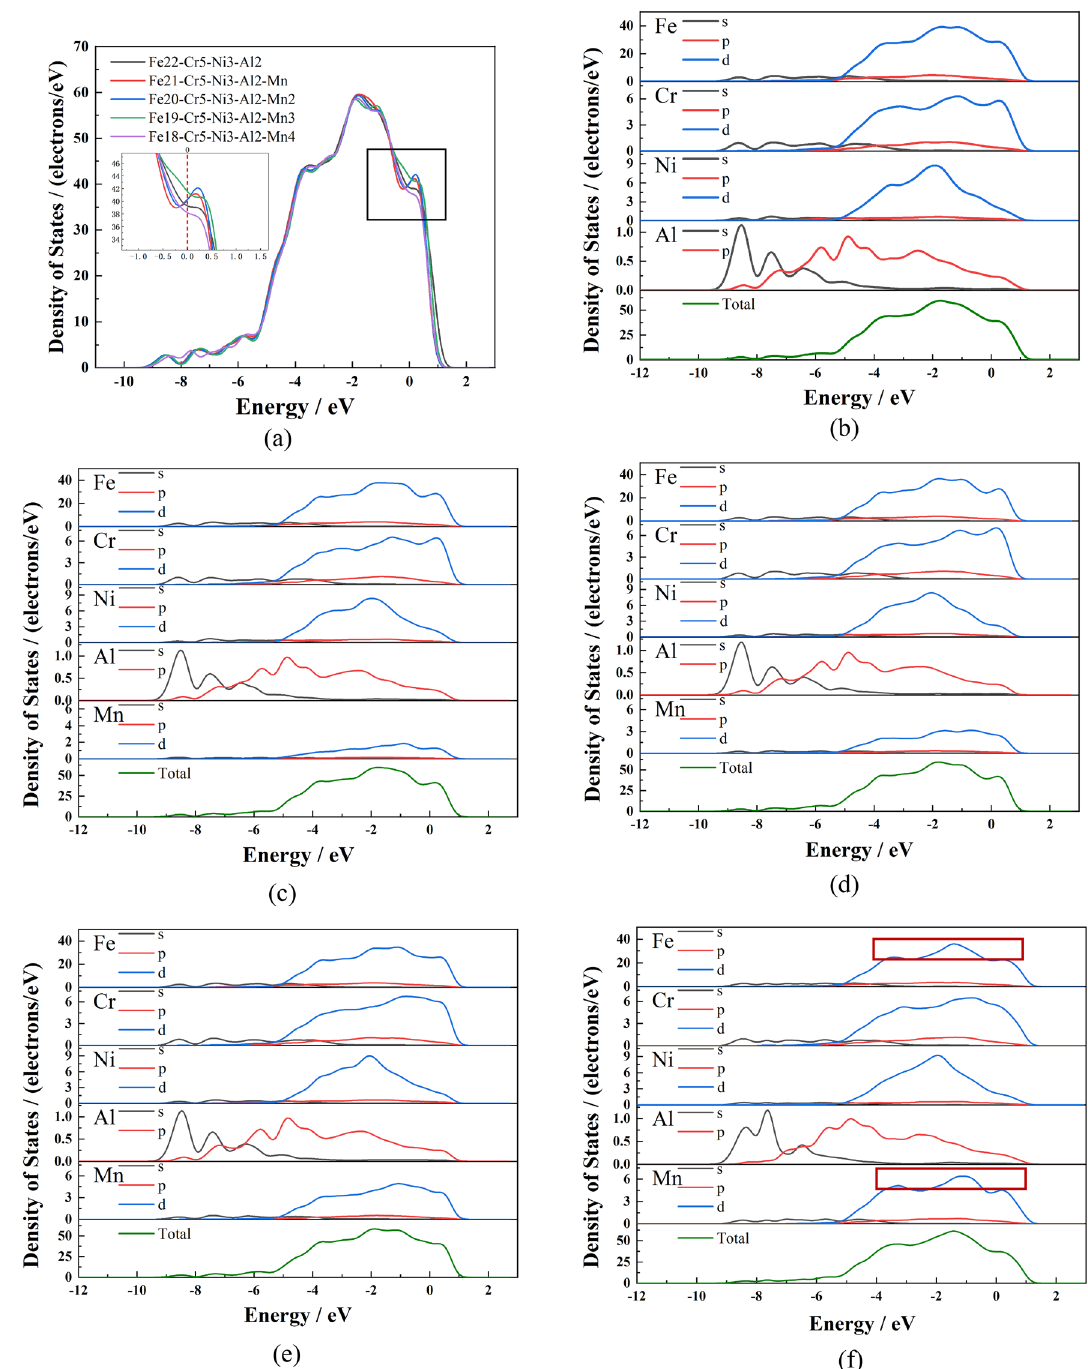
Figure 5. Total density of states and partial density of states of the five structural systems: ( a ) Total density of states ( b )